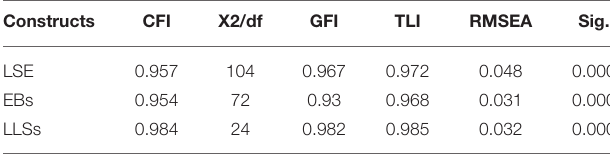
TABLE 4 | Conformity of measurement models with fitness indicators.